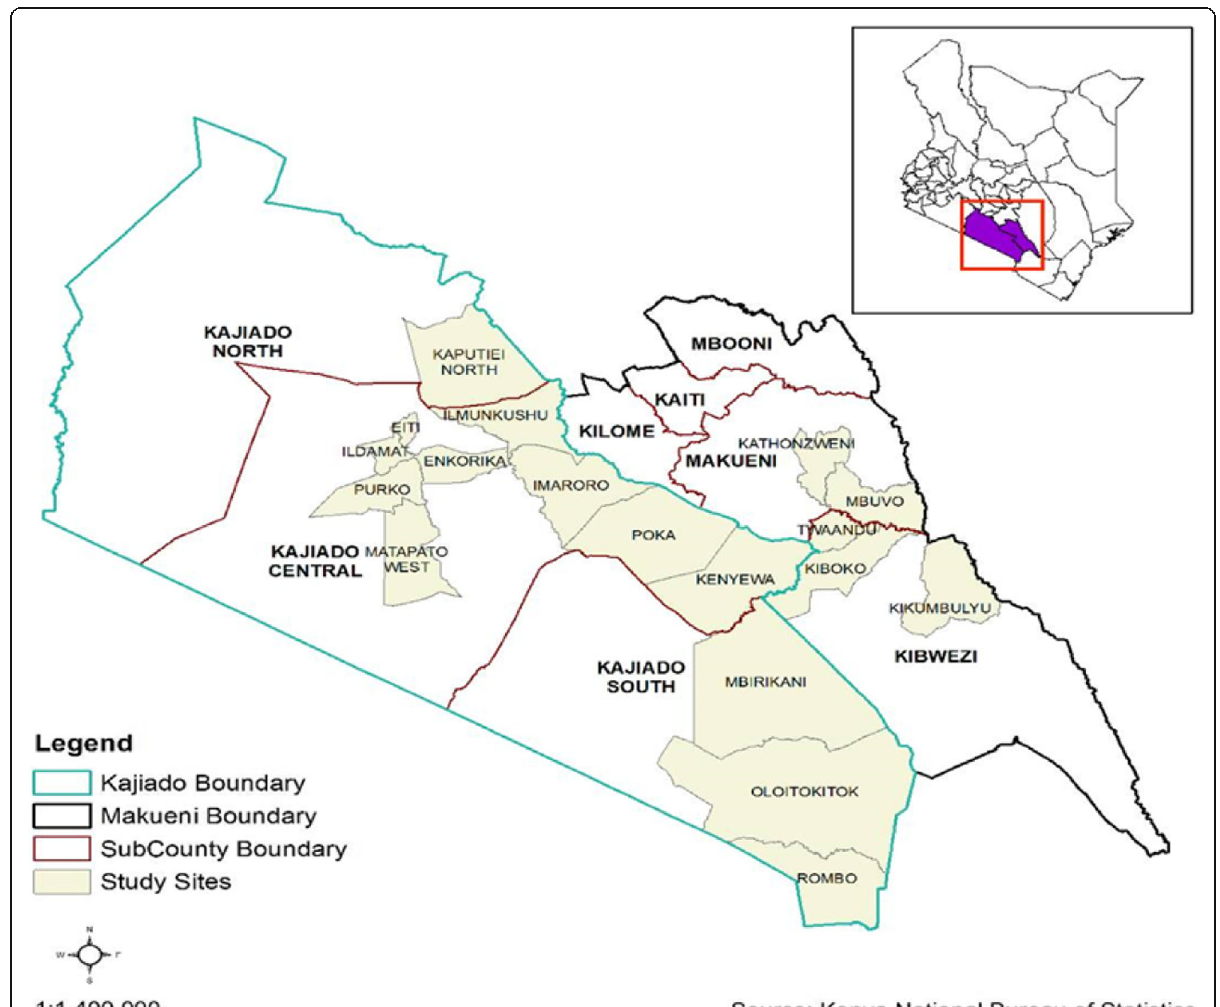
Figure 1 Map of Makueni and Kajiado